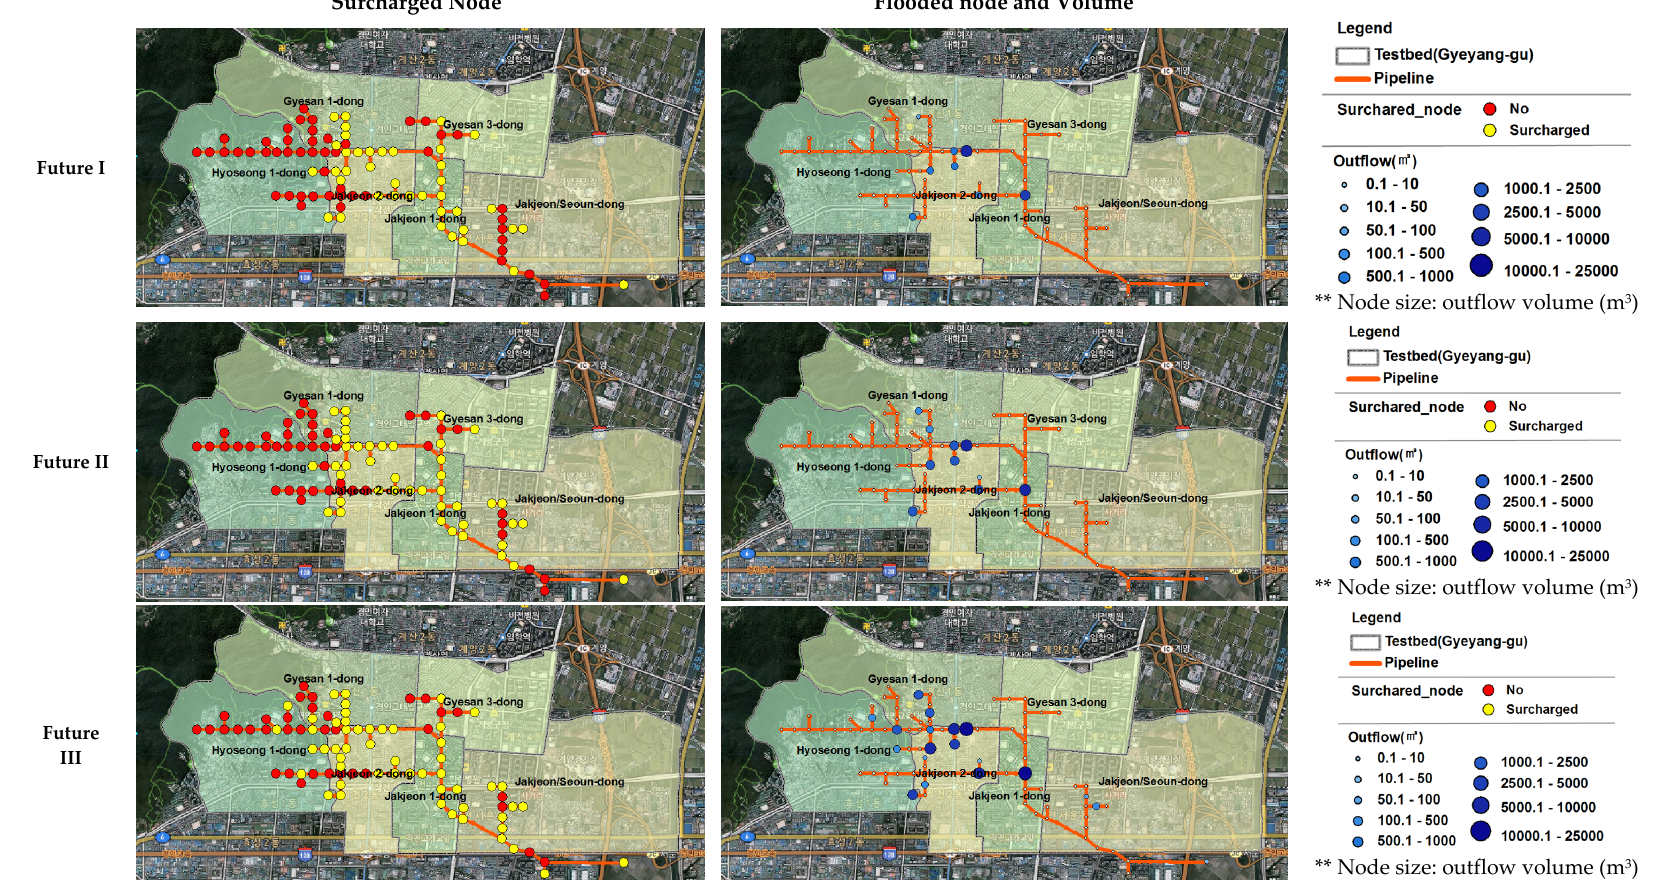
Figure 8. Surcharged nodes, flooded nodes, and flooded volume (m 3 ) for each target period Step (d): If the facility is not safe → Step (e).